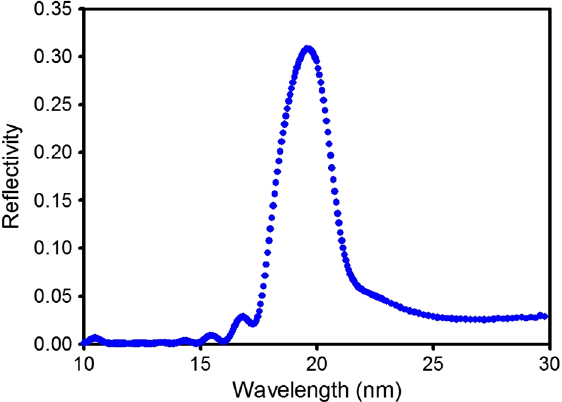
FIG. 7. Reflectivity curve of the spherical Mo = Si multilayer